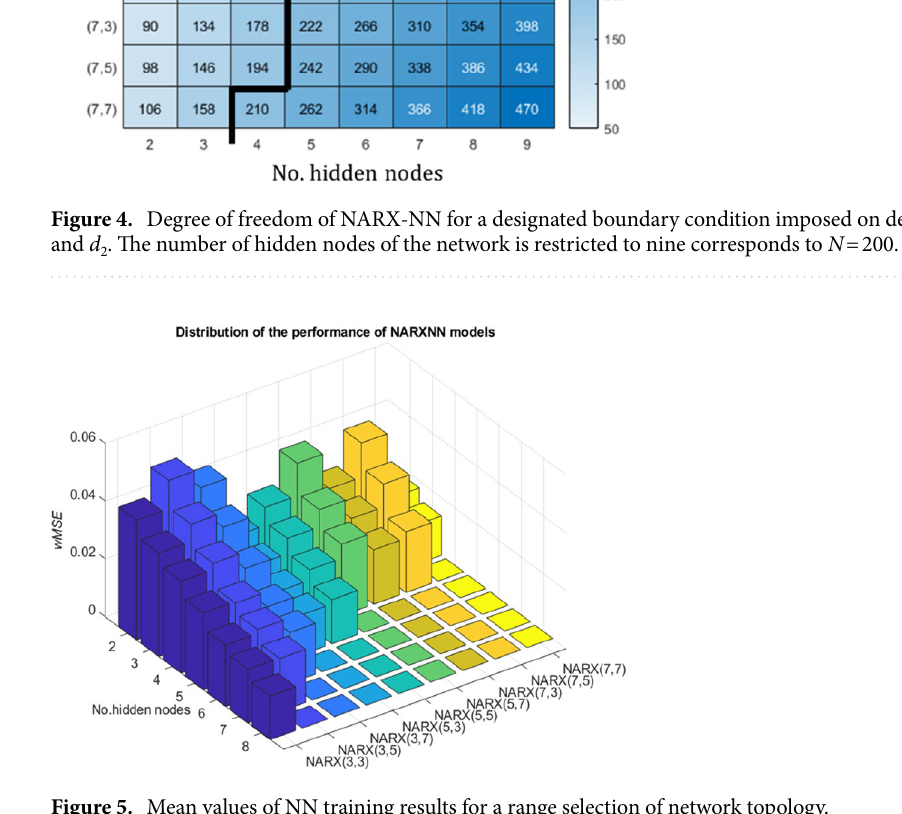
Figure 5. Mean values of NN training results for a range selection of network